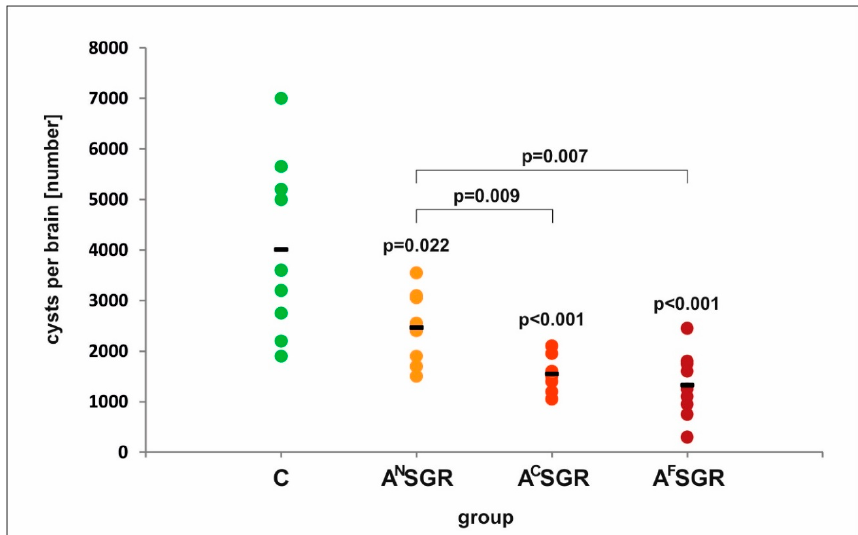
Figure 1. Cyst numbers in control and immunized mice challenged with T. gondii . p values are provided above the dots to indicate significant di ff erences in the cyst burden between immunized mice (A N SGR: n = 9; A C SGR: n = 8; A F SGR: n = 9) and control mice (C: n = 10); statistically significant di ff erences between immunized groups are marked with brackets; and the bars represent the mean cyst numbers in experimental